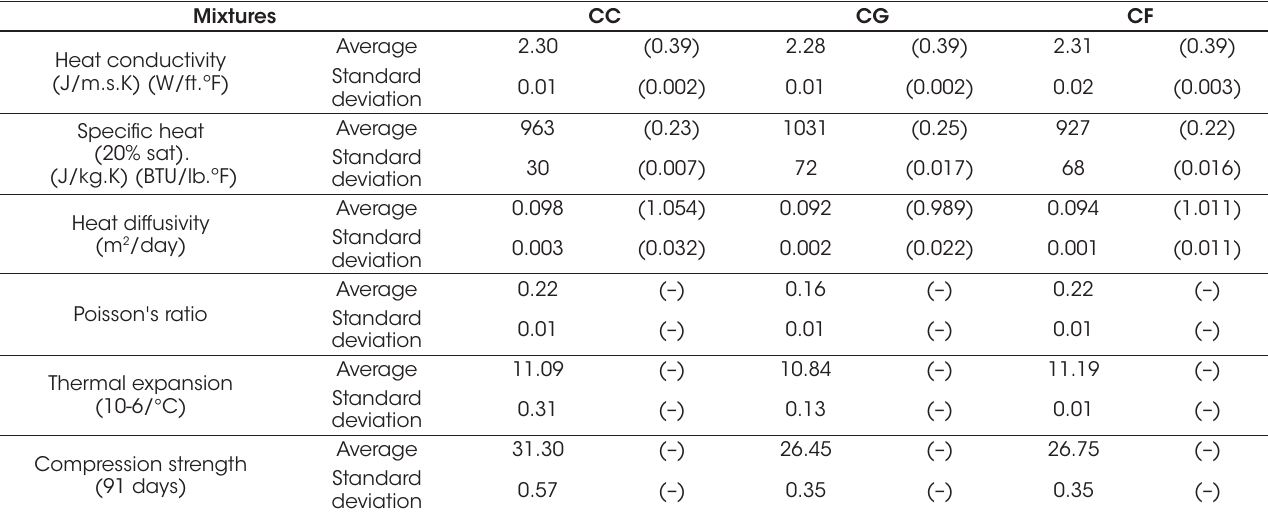
Average results of thermal and mechanical properties tests 6